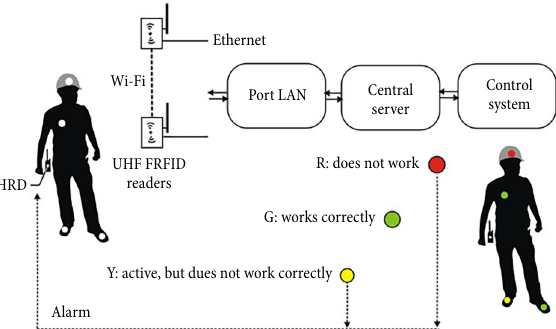
Fig. 4. An RFID model for port workers’ safety